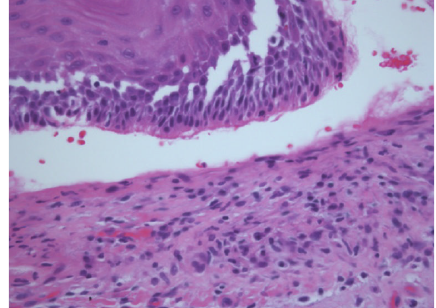
Figure 2: Histopathological examination of a bullous lesion revealed a subepithelial blister with a mostly lymphocytic and neutrophilic dense inflammatory infiltrate in the upper corion (hematoxylin and eosin, original magnification × 100).